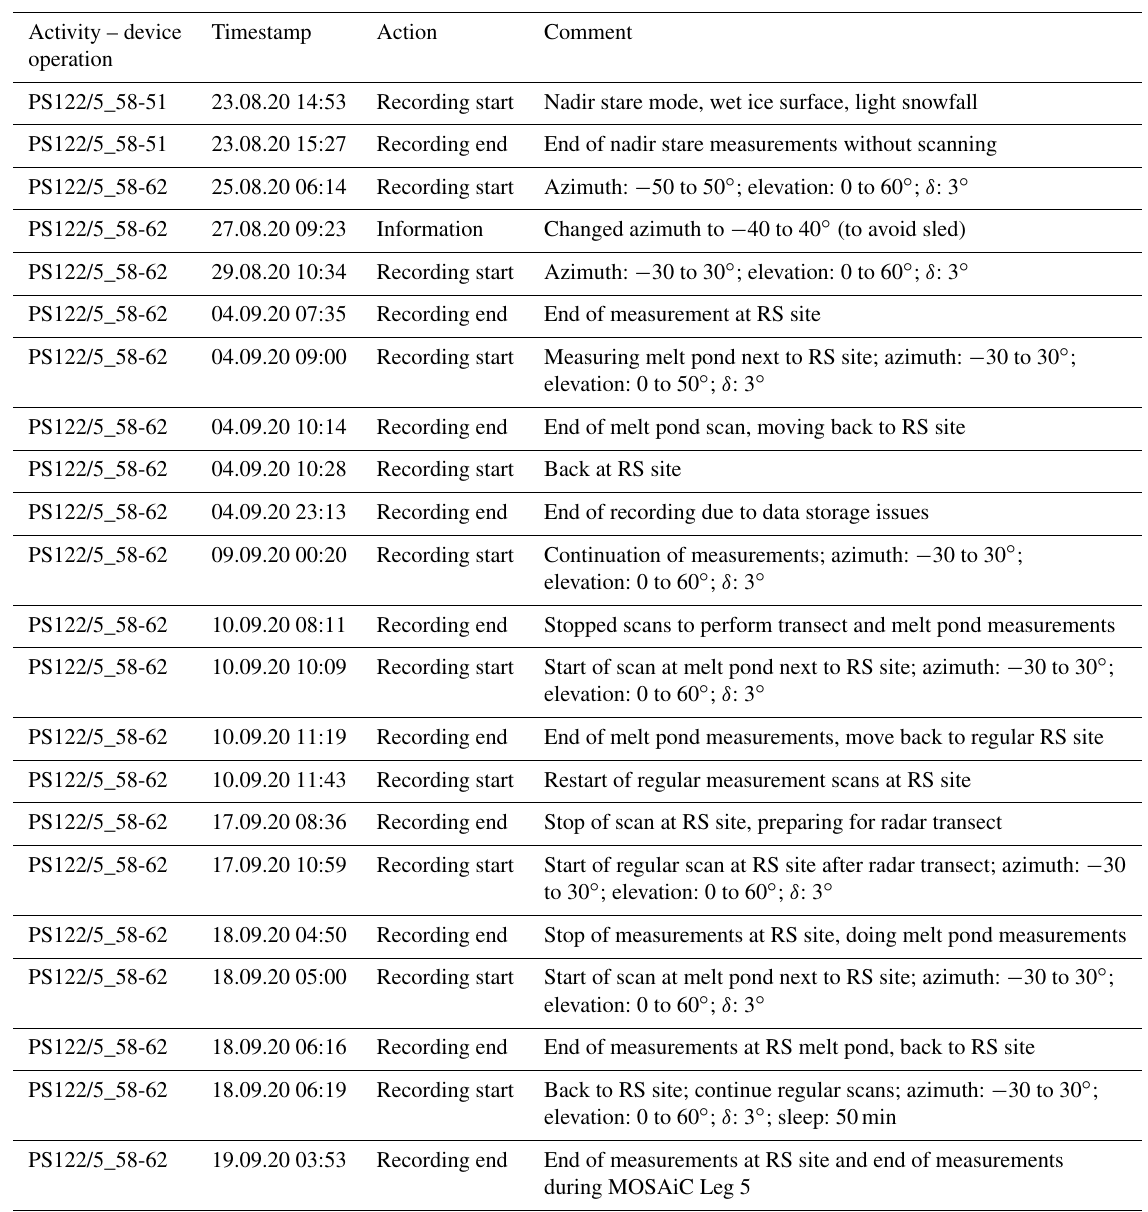
Table A1. List of measurement periods for the KuKa radar during Leg 5. Activity –